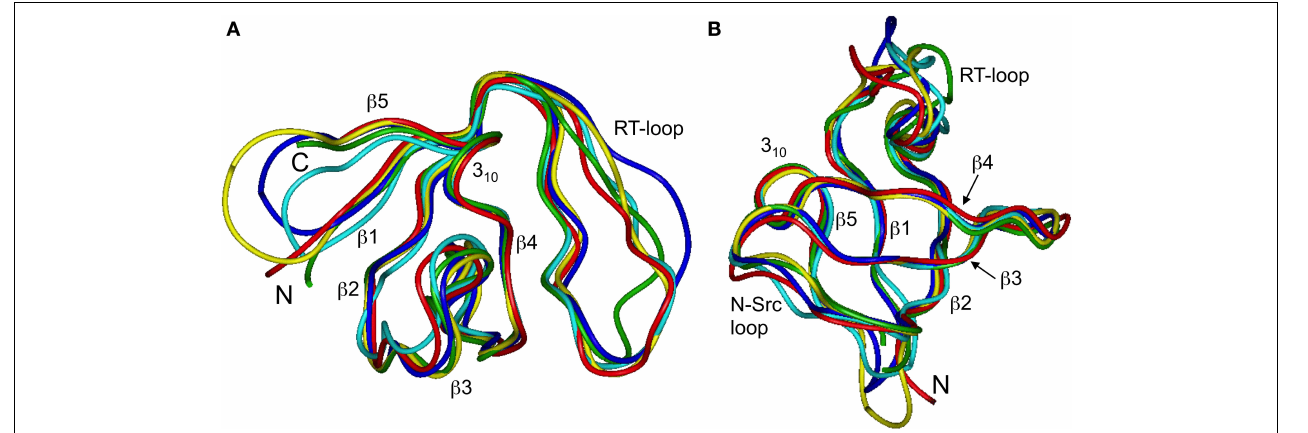
FIGURE 7 | Comparison of the 3D structure of the backbone for the circular SH3 constructs with the solution and the (ligand-bound) crystal (Wu et al., 1995) structures for the linear domain. The solution structures are represented by the mean structure for each ensemble, colored green (SH3 lin - wt ), cyan (SH3 circ - 1 ), blue (SH3 circ - G 1 ), and yellow